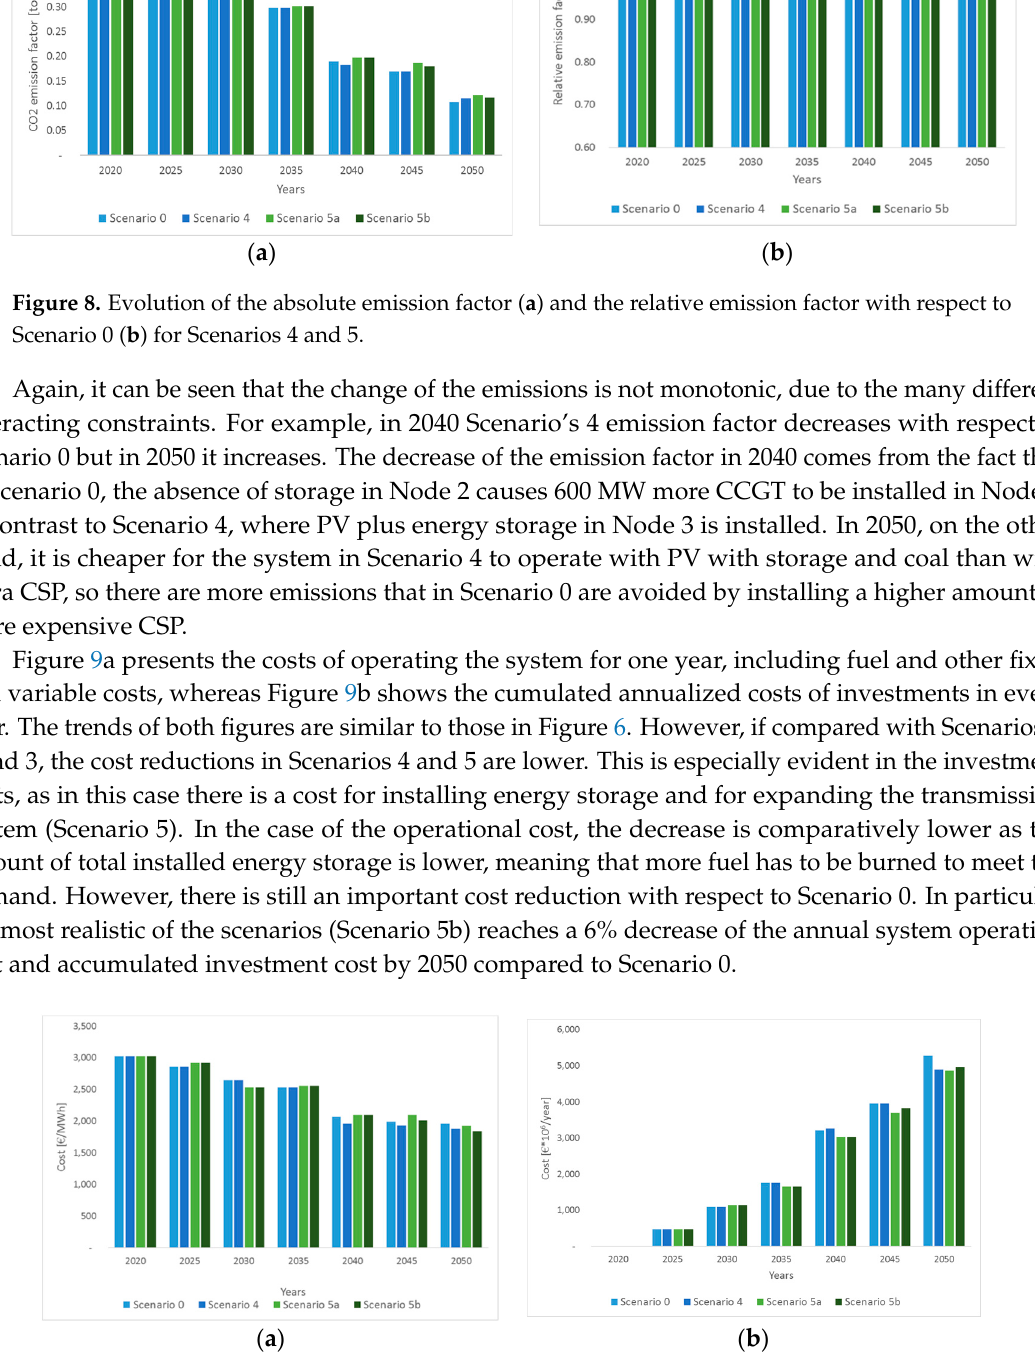
(b) Figure 7. Evolution of the installed capacity ( a ) and energy generation ( b ) of PV and wind for Scenarios 4 and 5. Figure 8a presents the absolute emission factor of the system for the different scenarios, while Figure 8b presents their evolution relative to Scenario 0. Similarly to Figure 5a, it is evident that the general decreasing trend is driven by the decommissioning of ageing coal generation. In contrast to Scenarios 1 to 3, this figure shows that Scenarios 4 and 5 have relatively higher emissions than Scenario 0. This is counter-intuitive, especially for Scenario 4, as it has the same transmission expansion than Scenario 0 but also has the option of installing energy storage, which allows an increase in the installed capacity of PV and wind. However, as the solar resource is particularly good in northern Chile, CSP with thermal storage becomes competitive with conventional options and is installed instead. Again, it can be seen that the change of the emissions is not monotonic, due to the many different interacting constraints. For example, in 2040 Scenario’s 4 emission factor decreases with respect to Scenario 0 but in 2050 it increases. The decrease of the emission factor in 2040 comes from the fact